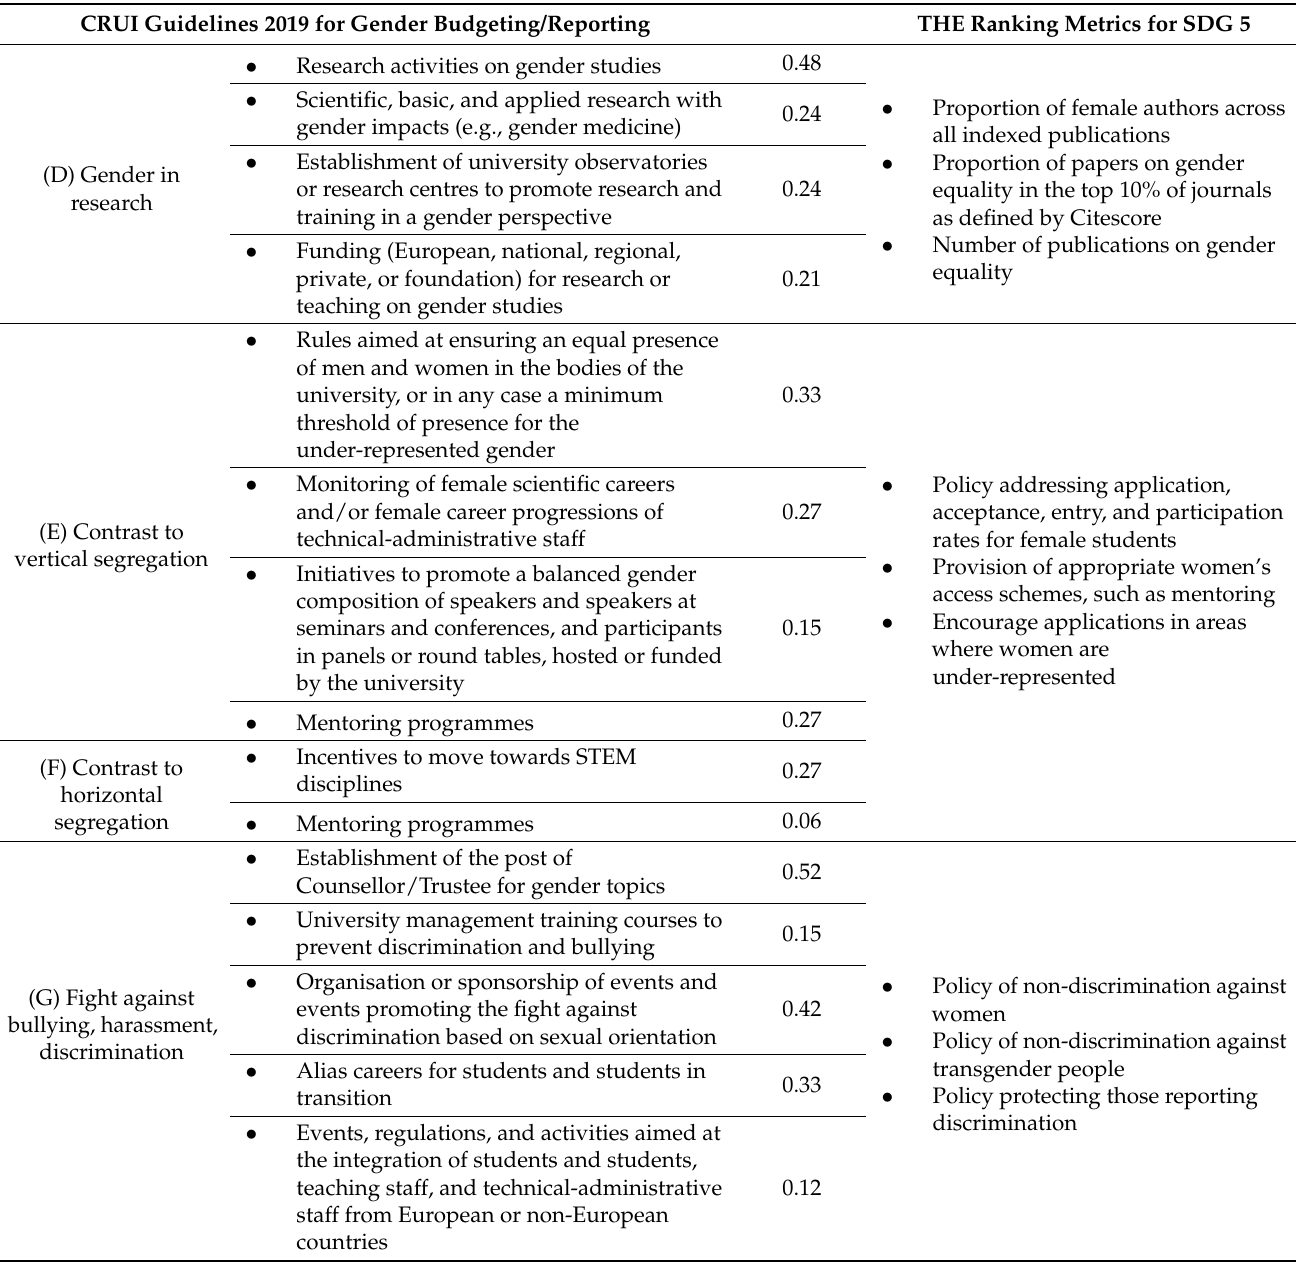
Table 4. Cont. CRUI Guidelines 2019 for Gender